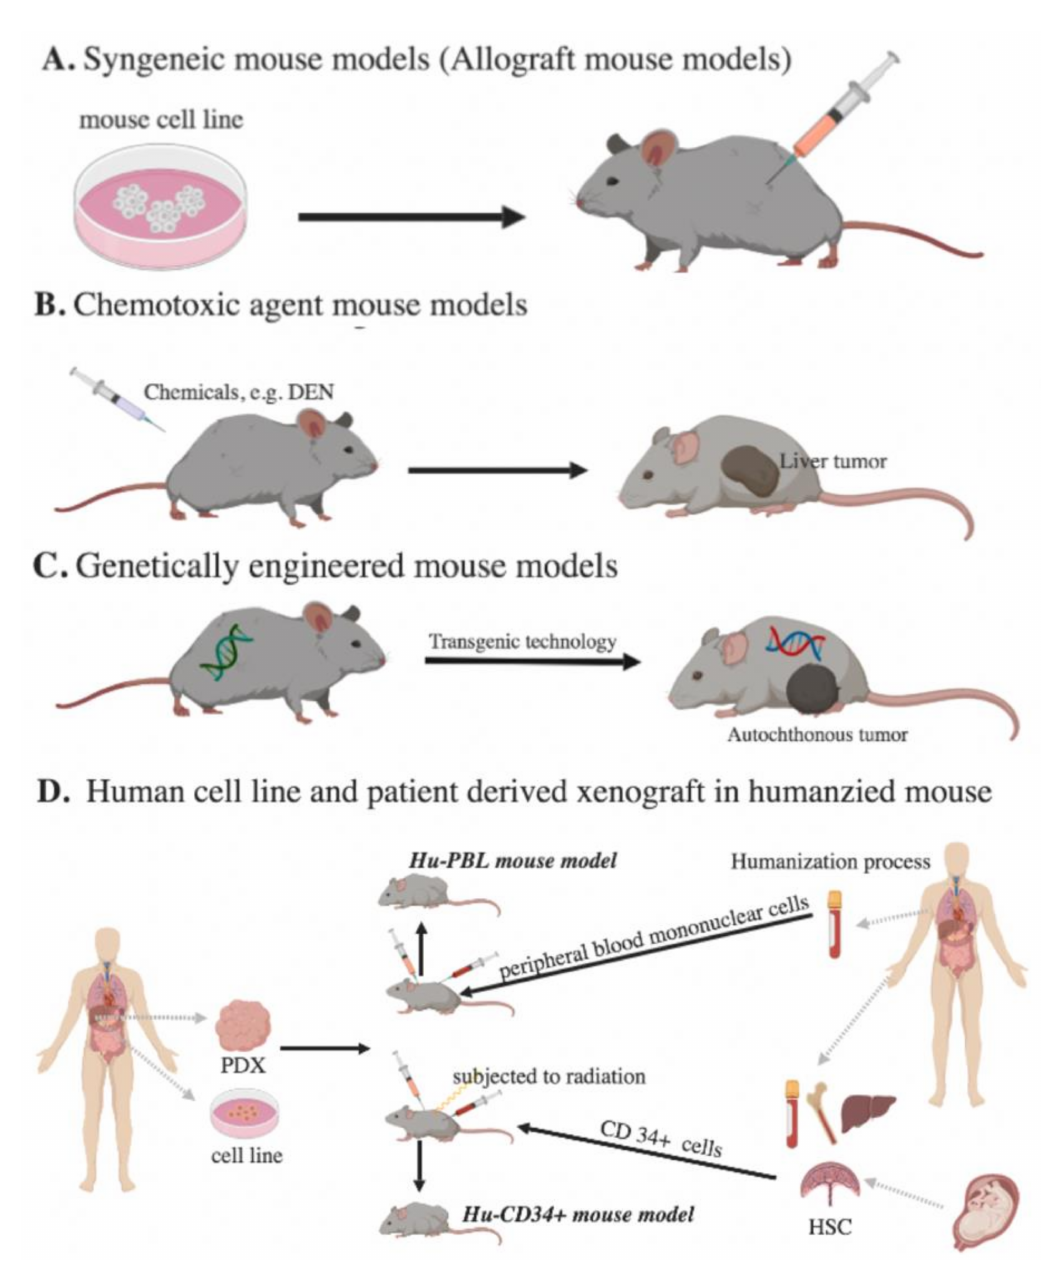
Figure 1. Murine models for immunotherapy studies of HCC. ( A ) Syngeneic mouse models: Mouse tumor cells are implanted in immune-competent mice. ( B ) Chemotoxic agent mouse models: Chemicals are administered to induce HCC growth. ( C ) Genetically engineered mouse models: Tumor suppressor gene deletion or oncogene activation is built into mice. ( D ) Human cell line and patient-derived xenograft in humanized mouse models: Human peripheral blood mononuclear cells (PBMC) or human CD34 + cells are given to immunodeficient mice. (PDX, patient-derived xenografts; Hu-PBL, PBMC-humanized mouse model; HSC, hematopoietic stem